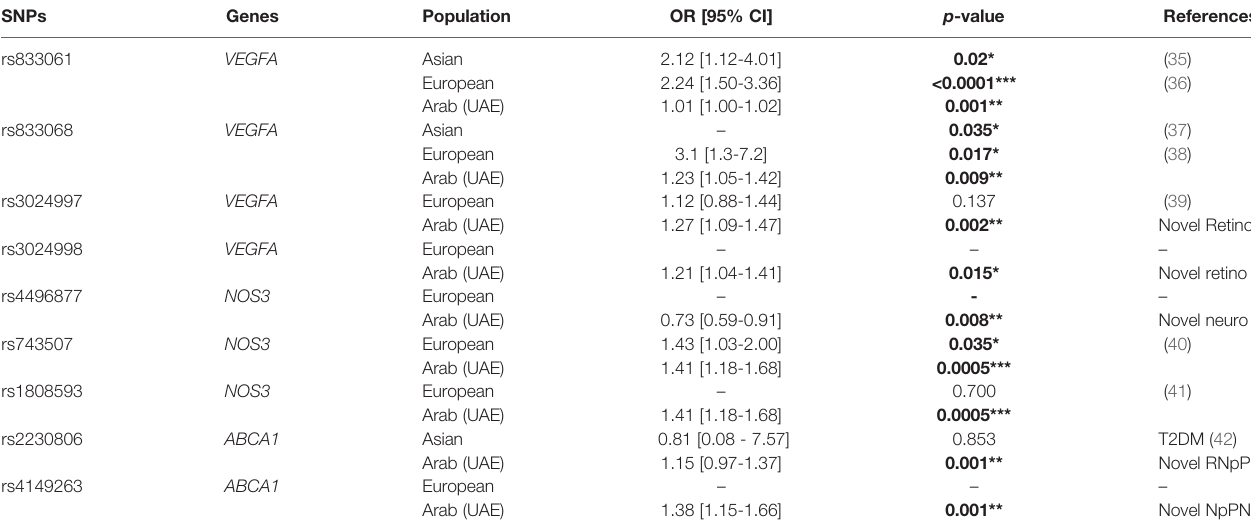
TABLE 5 | Comparison of association studies on diabetic complications between the UAE population and other ethnic groups. SNPs